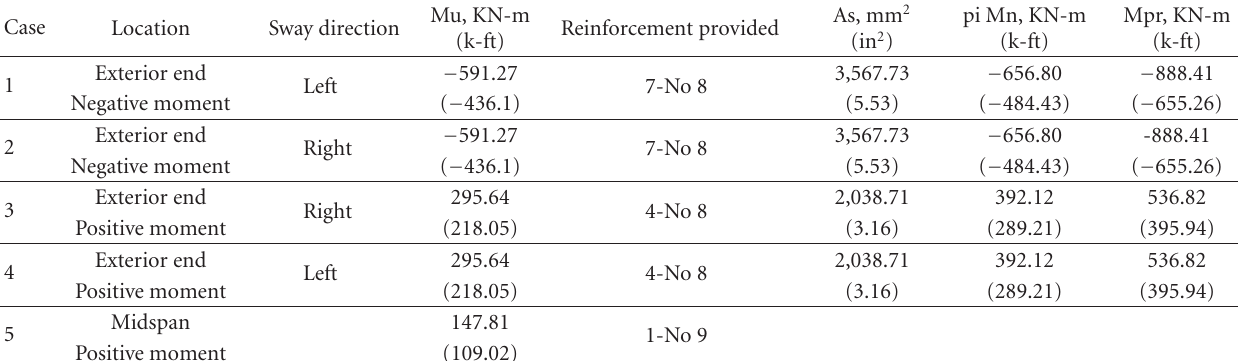
Table 1: Details of beam B1.